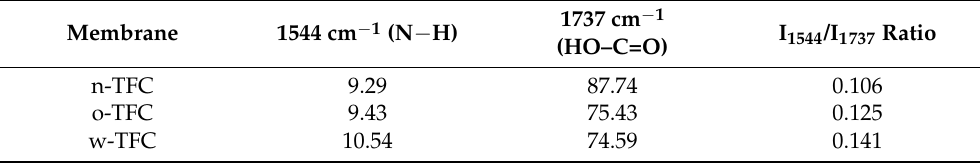
Table 4. Two curve-fitted peak components of high-resolution O 1s of nanofiber-supported PA